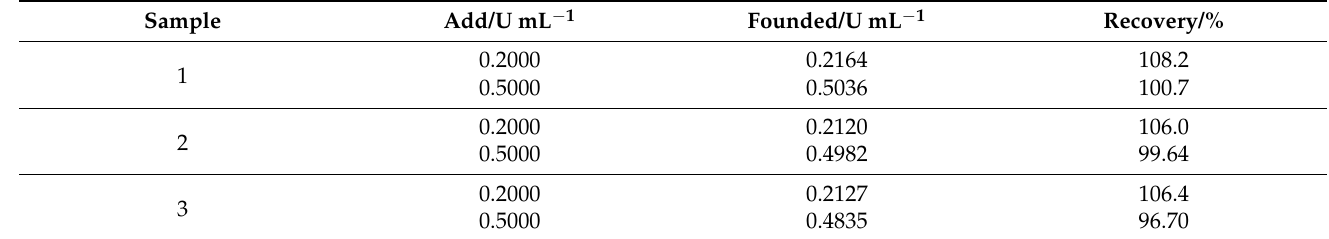
Table 2. The recoveries for ALP determination in